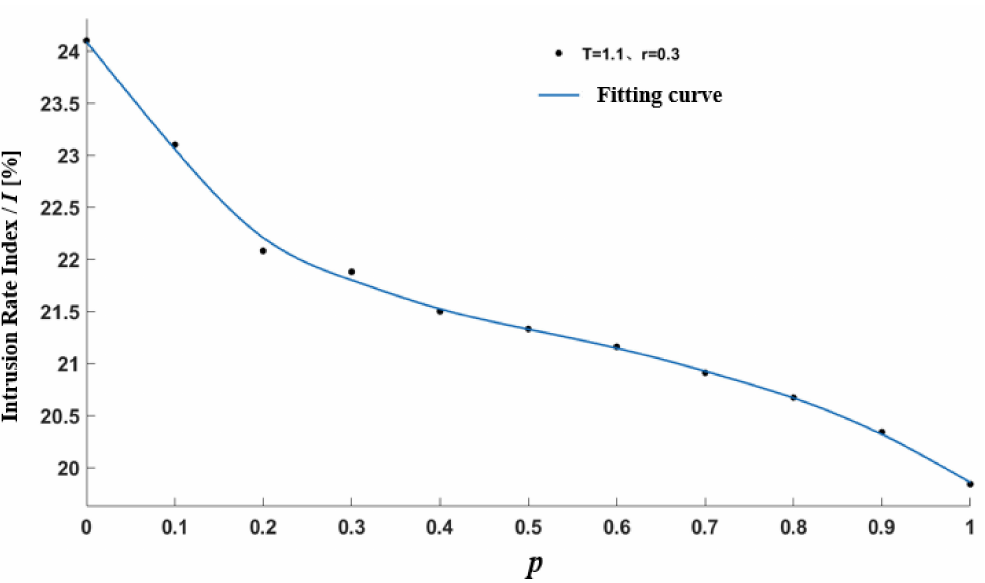
Figure 11. Fitting curve of average intrusion